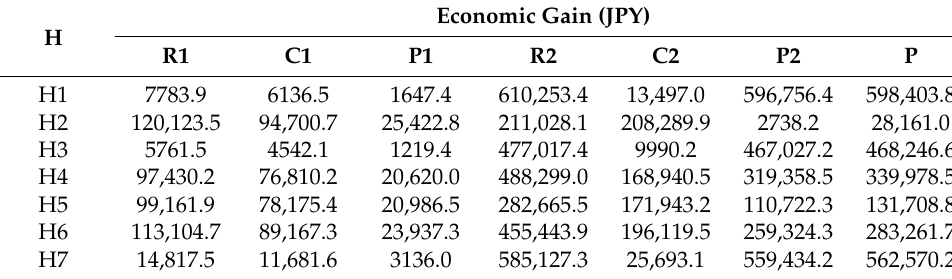
Table 9. Expected economic gains 1